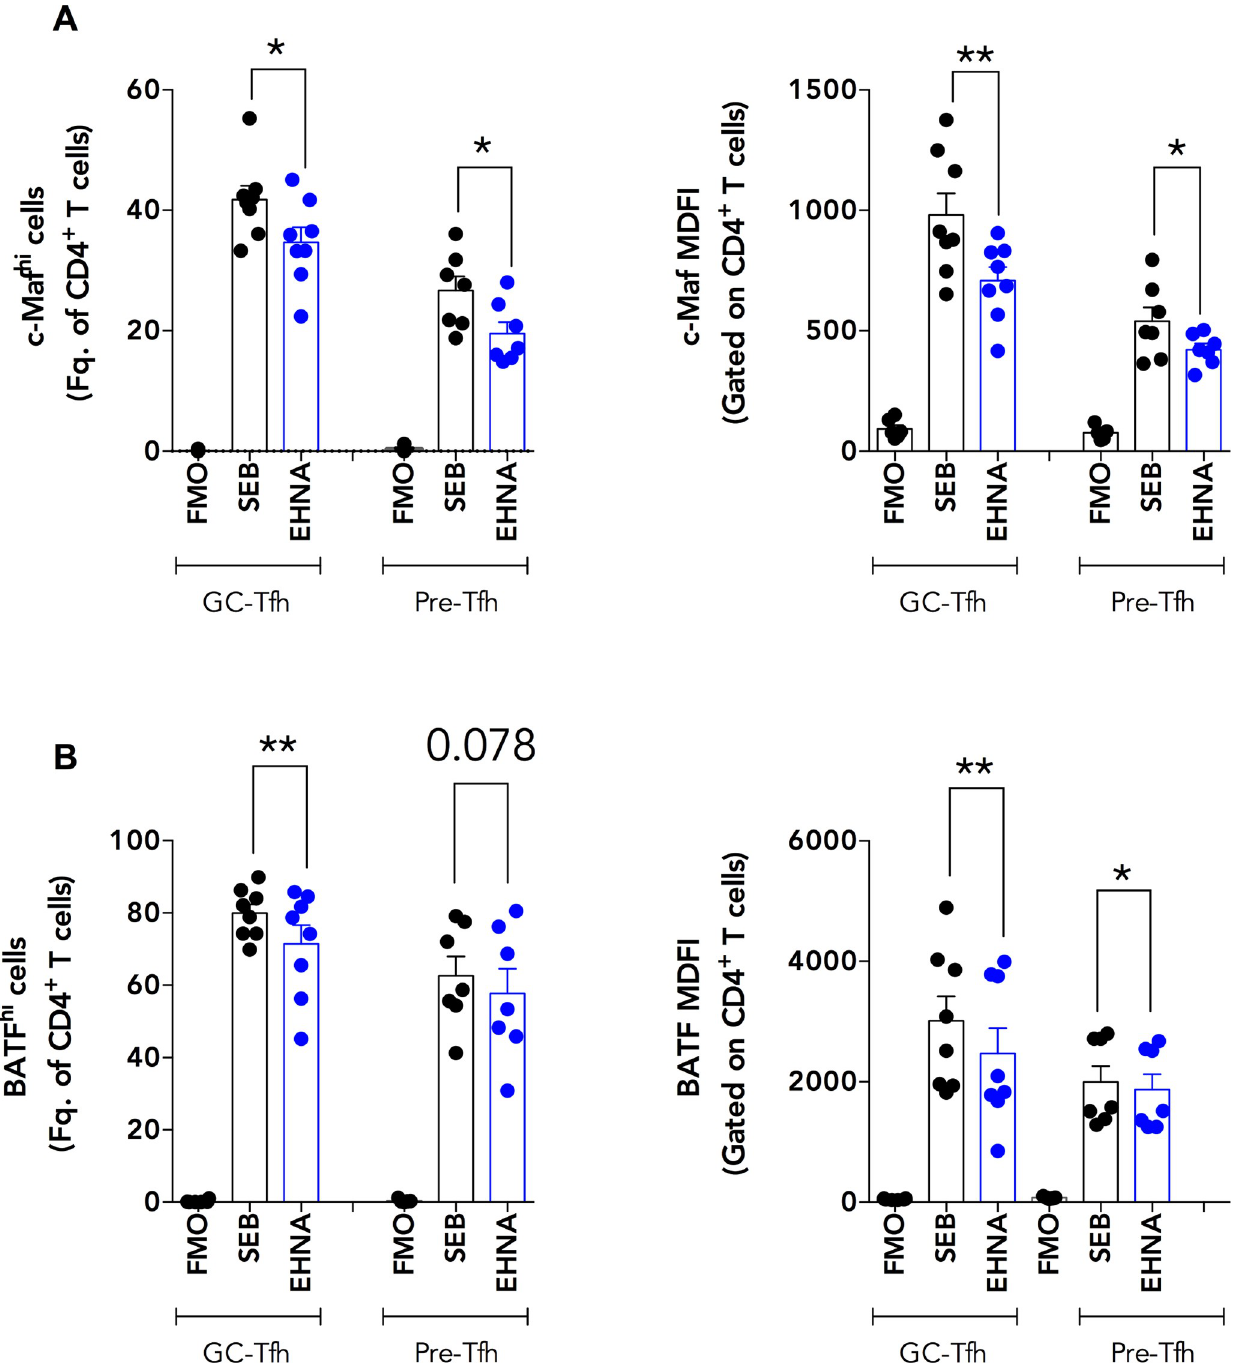
Fig 6. Specific ADA-1 blockade reduces c-Maf and BATF expression in healthy tonsillar GC-Tfh and pre-Tfh cells. We sorted GC-Tfh, pre-Tfh and autologous GC-B cells from the tonsils of healthy individuals and co-cultured GC-Tfh:GC-B as well as pre-Tfh:GC-B cells in a 1:1 ratio in the presence of SEB (SEB) with or without 10uM specific ADA-1 inhibitor EHNA (EHNA). We harvested the cells one day after co-culture and performed intracellular flow cytometry staining for c-Maf and BATF expression in GC-Tfh and pre-Tfh cells. (A) shows the percent of c-Maf hi GC-Tfh and pre-Tfh cells in the total CD4 + T cell population (left) and c-Maf median fluorescence intensity (MDFI) in GC-Tfh and pre-Tfh cells , gated on the total CD4 + T cells (right) (n = 7–8). (B) shows the percent of BATF hi GC-Tfh and pre-Tfh cells in the total CD4 + T cell population (left) and BATF median fluorescence intensity (MDFI) in GC-Tfh and pre-Tfh cells , gated on the total CD4 + T cells (right) (n = 7–8). Negative controls are labeled as Fluorescence Minus One (FMO). Results are from 3 independent experiments and are represented as mean ± SEM. Data was analyzed with the two-tailed paired non-parametric Student’s t- test using the Wilcoxon matched-pairs signed rank test. Nominal p-values p < 0.05 were considered of statistical significance. � p < 0.05 and �� p < 0.01.